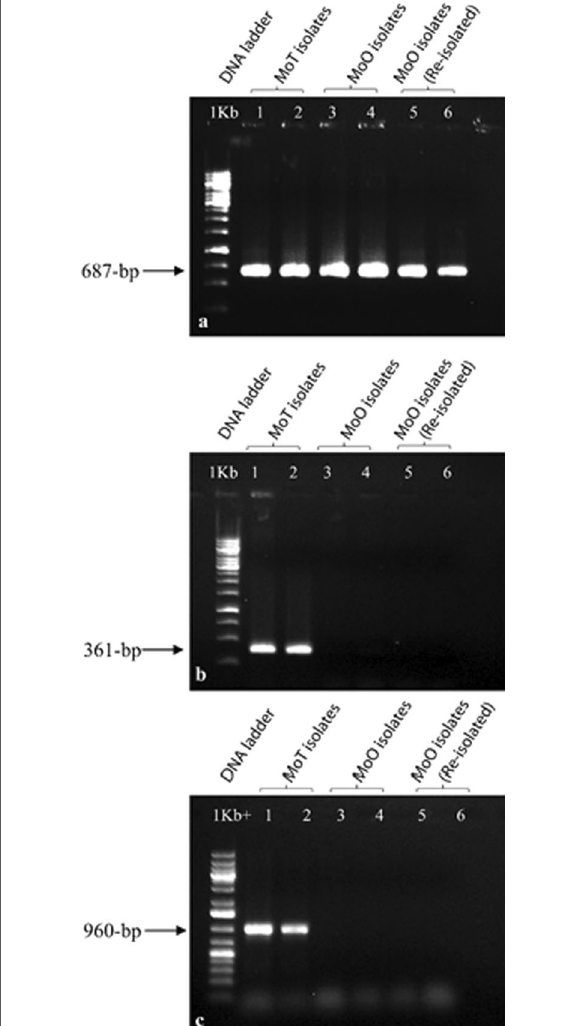
Fig. 5 PCR detection of MoT and MoO pathotypes. The gel images of PCR products amplified by Pot2 ( a ), MoT3 ( b ) and MoT6099 primers ( c ) to confirm the M. oryzae pathotype. The gDNA used in this study was isolated from mycelia of the respective fungus. Lane 1, DNA ladder; Lanes 2 and 3 represent DNA isolated from MoT strains BTJP4‑5 and BTMaU(10b), respectively, which were collected from naturally blast infected wheat field; Lanes 3 and 4 denote DNA isolated from MoO isolates RB13b and RBTa1849‑2, respectively, which were collected from naturally blast infected rice field; Lanes 5 and 6 represent DNA reisolated from the symptomatic tissues of wheat spikes artificially inoculated with the MoO strains RB13b and RBTa1849‑2, respectively